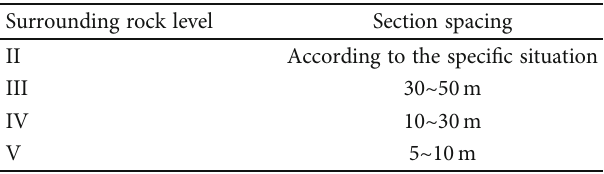
Table 2: Principles for selecting monitoring surfaces.